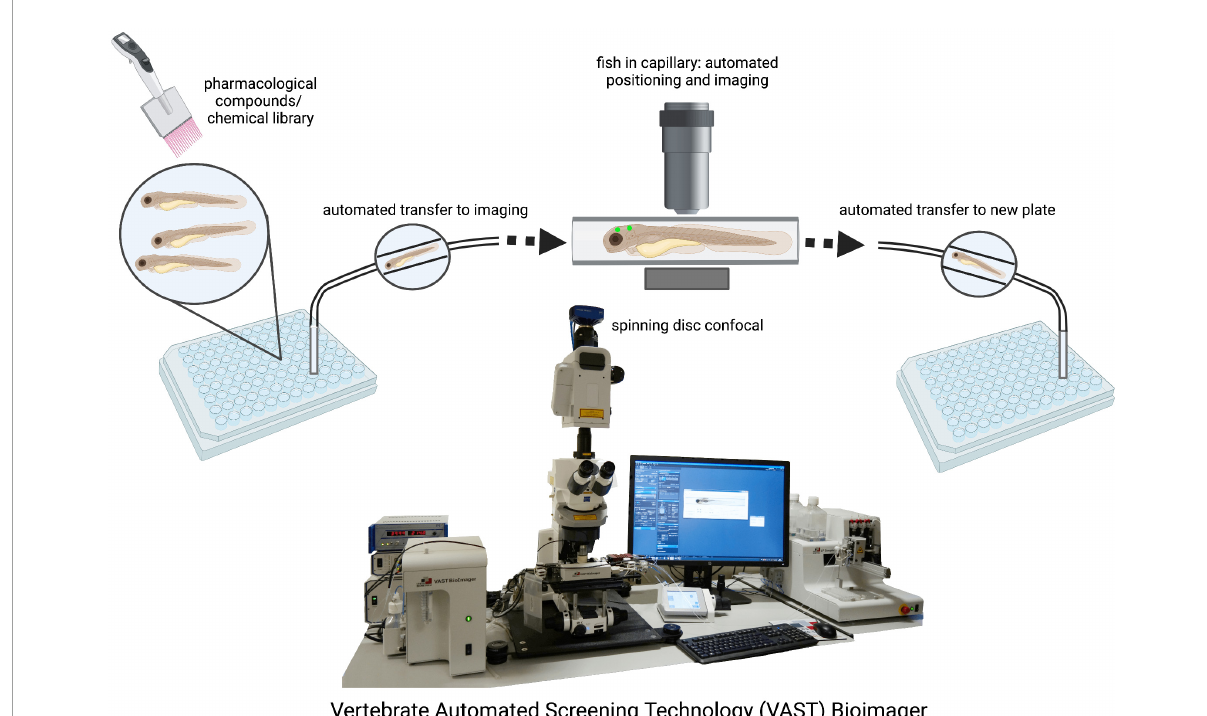
FIGURE2 Drug screening and automated imaging as well as analysis of zebrafish larvae. The VAST system is a fully validated, highly accurate integrity screening system that provides a method of screening large population numbers rapidly. Automated imaging and analysis pipelines ensure unbiased and fast data generation. VAST Bioimager photo provided by Dr. Jason Early